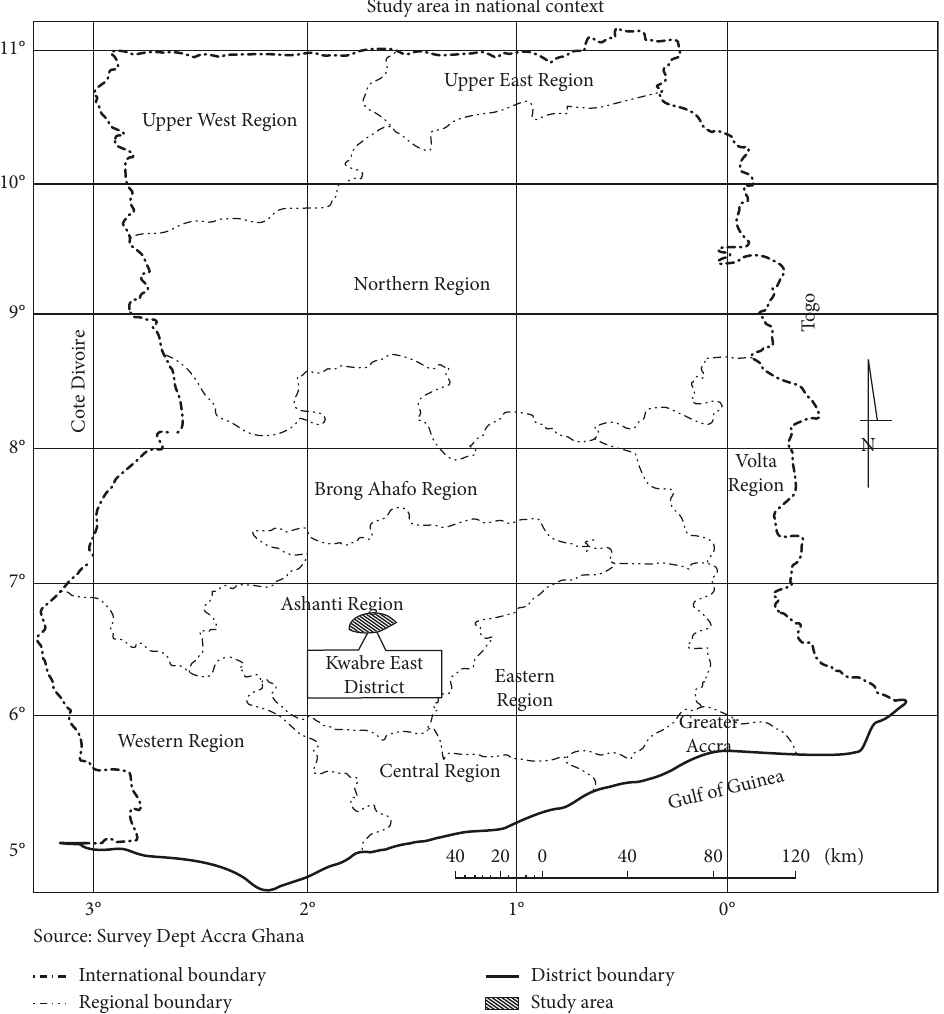
Figure 1: Study district in national context. Source: Kwabre East District Assembly